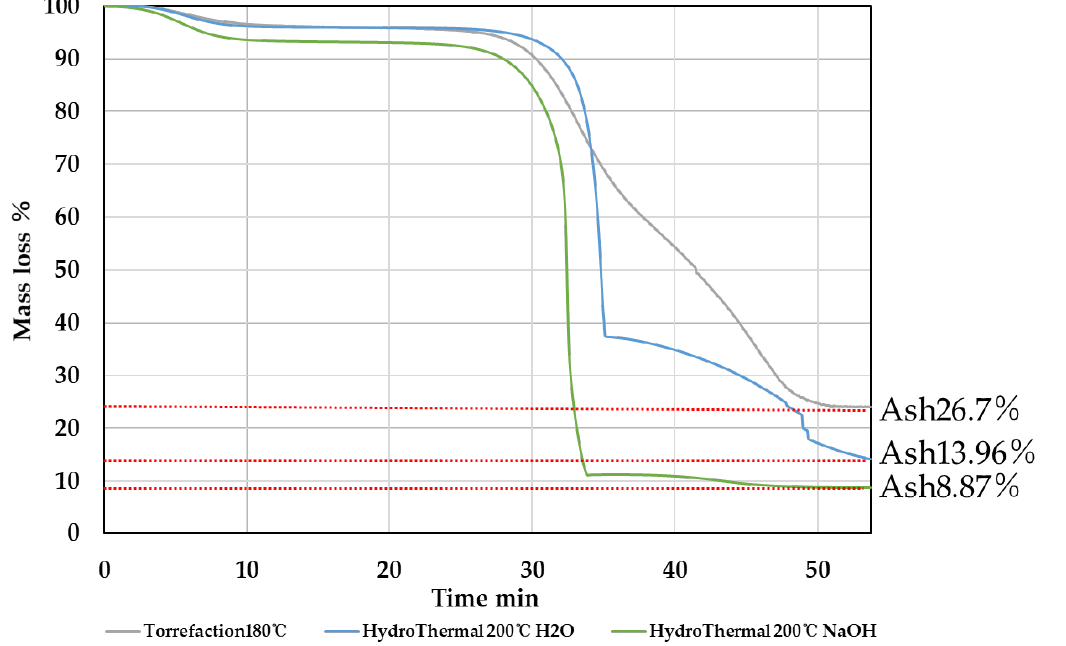
Figure 15. Comparison of the rice husk torrefaction and hydrothermal products.